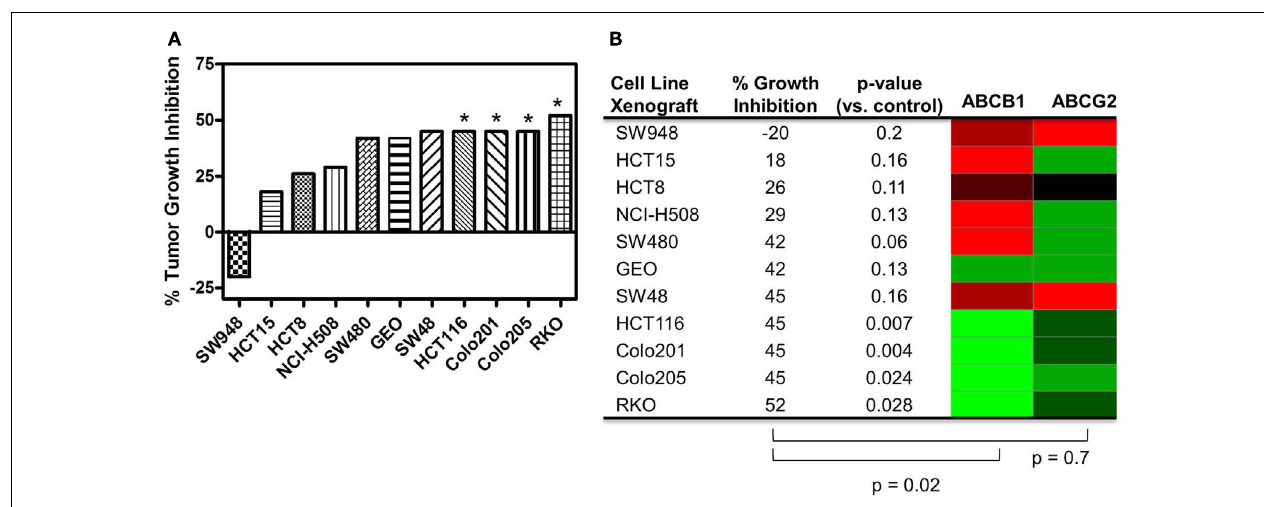
represents high expression and green represents low). Spearman correlation of ABCB1 relative expression and % growth inhibition showed a significant correlation ( p = 0.02), while ABCG2 did not ( p = 0.7).Tumor models that were unresponsive to treatment (growth inhibition < 40%) had high relative levels of ABCB1 . Conversely, the most responsive tumors had statistically significant differences between controls and treated groups, had average growth inhibition > 40% and displayed relative low ABCB1 levels.